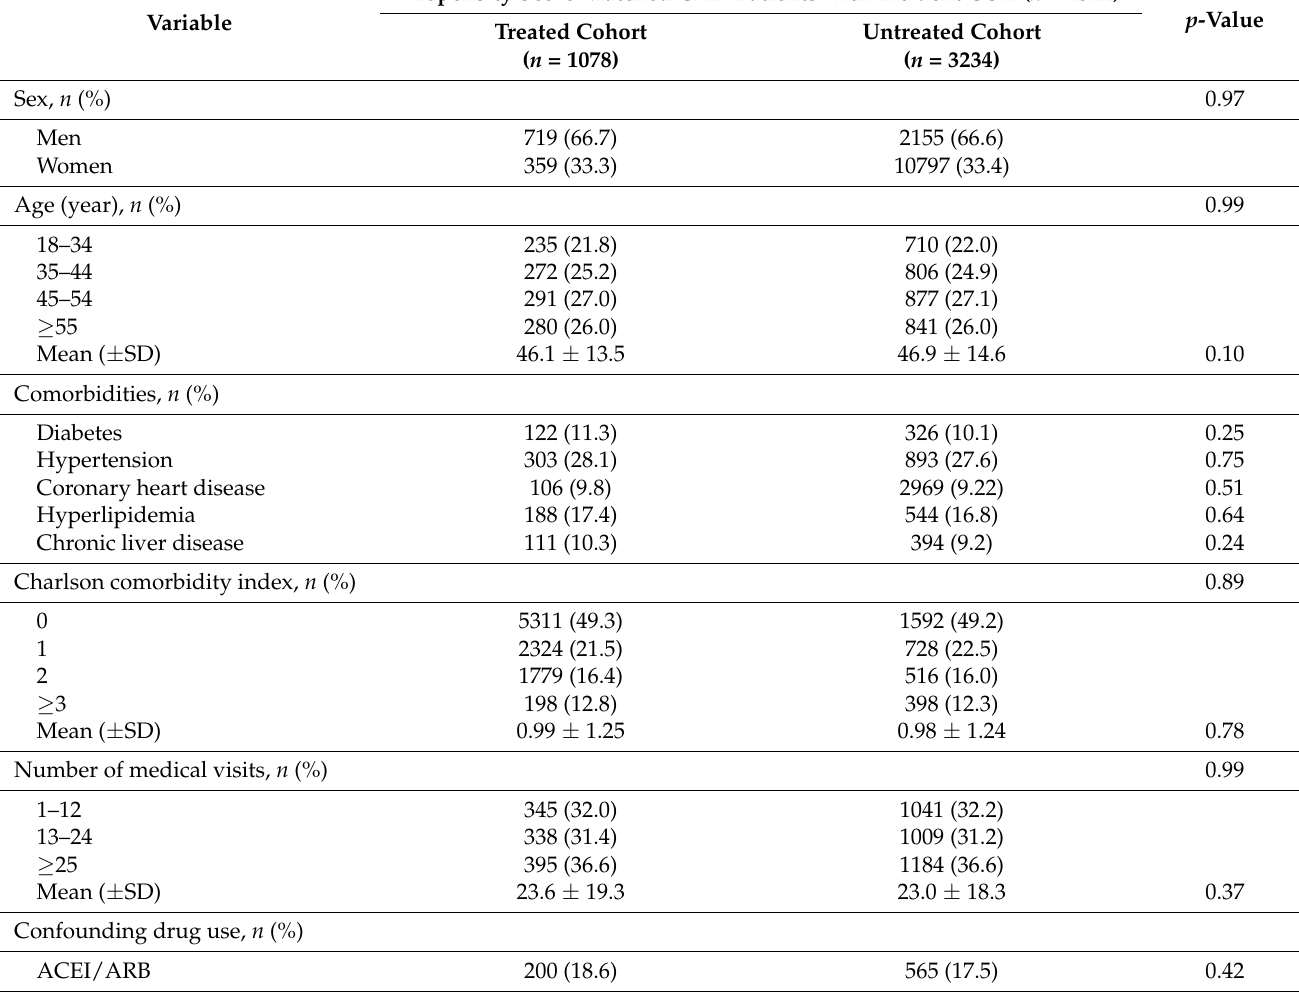
Table 1. Baseline characteristics of CKD patients with incident obstructive sleep apnea (OSA) by the use of surgical treatment for